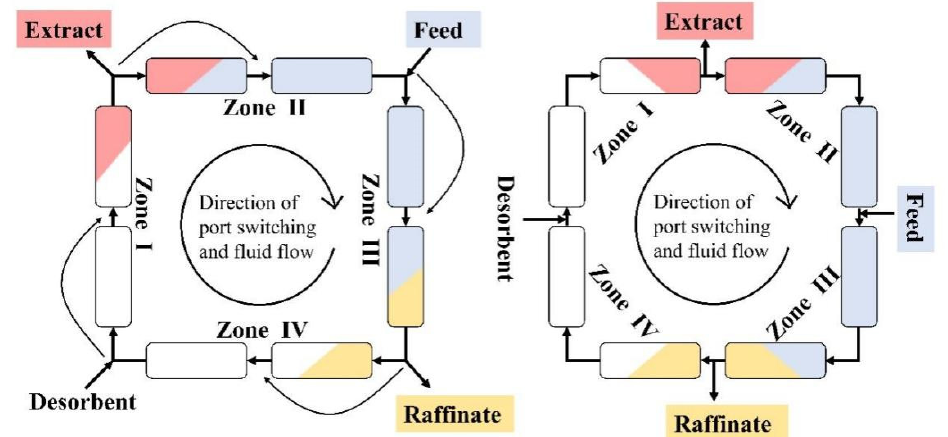
Figure 2. Schematic diagram of Simulated Moving Bed.